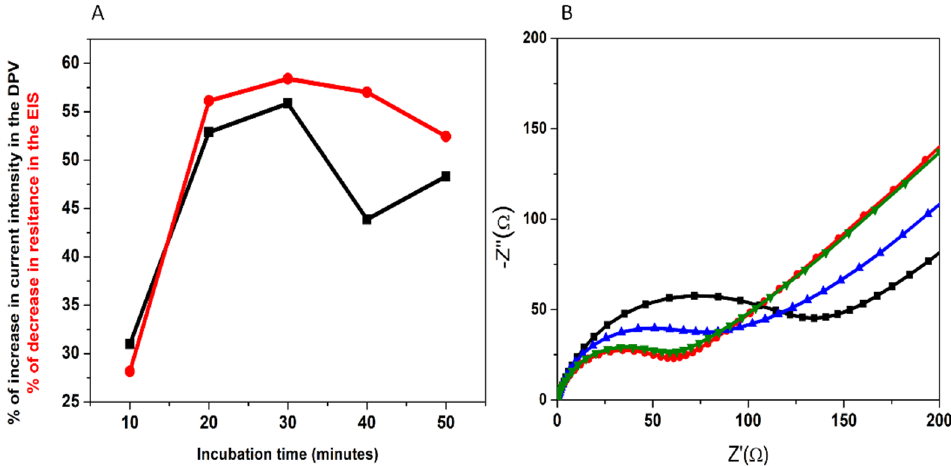
Figure 4. The influence of the incubation time on the electrochemical signal in DPV and EIS ( A ). The influence of the incubation dynamics ( B ): APT immobilization for static incubation ( black ); static incubation with 10 µM 3-O-C 12 -HSL ( red ); APT immobilization for dynamic incubation ( blue ); dynamic incubation with 10 µM 3-O-C 12 -HSL ( green ).